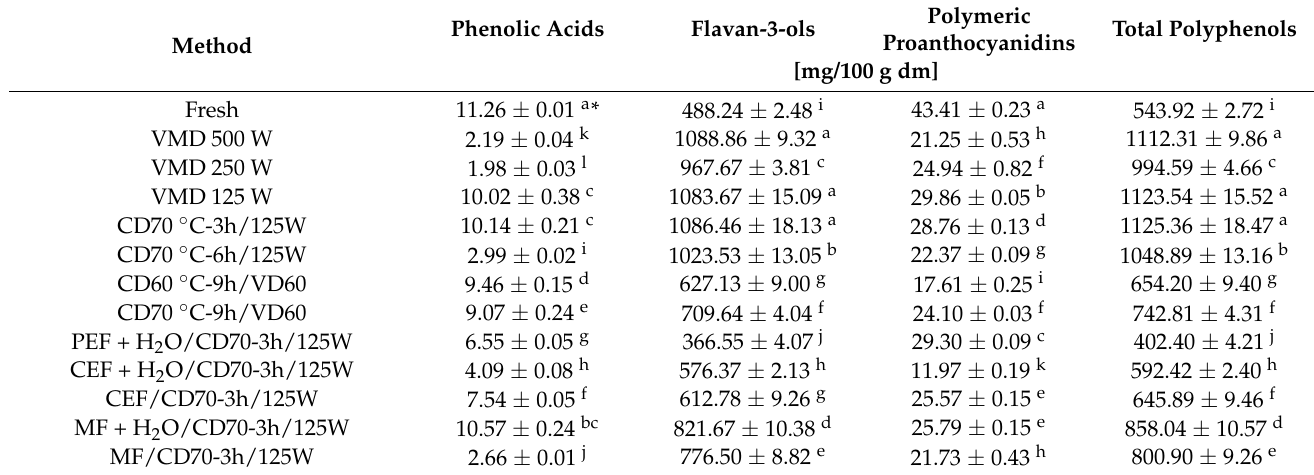
Table 3. The content of phenolic compounds in black garlic after pretreatments and